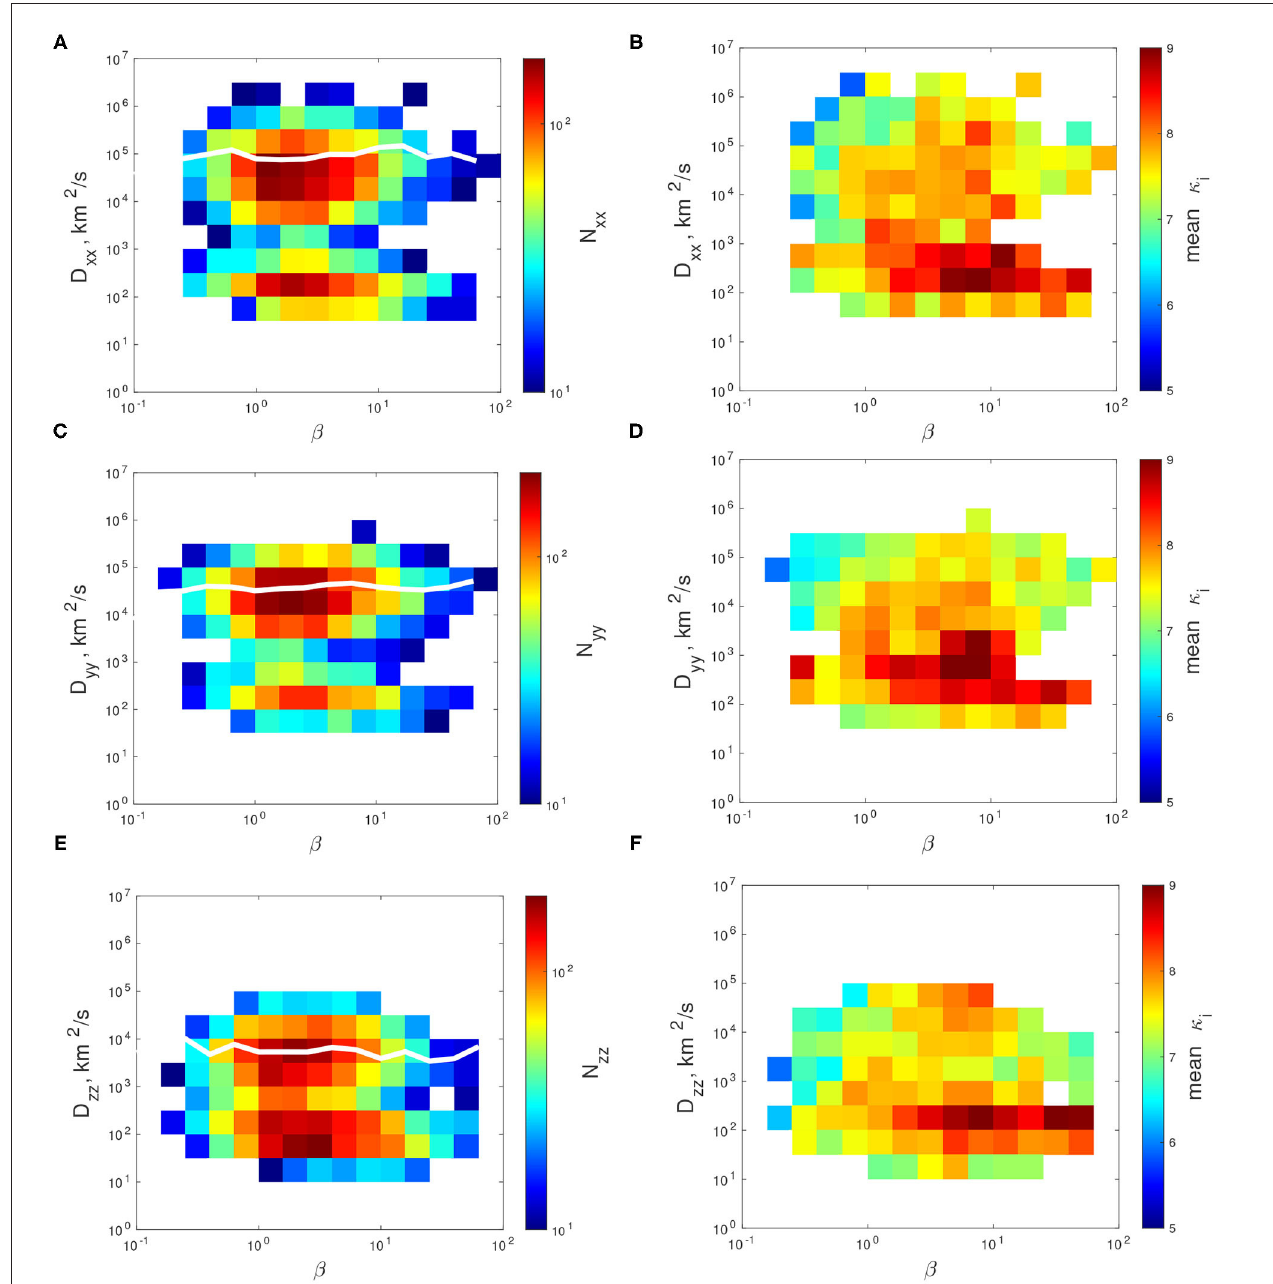
FIGURE 5 | Eddy diffusion coefficients and κ indices as a function of β . Left column (A,C,E) : the number of measurements in each cell. Right column (B,D,F) : average values of the κ index. Only bins with 10 or more measurements are colored.